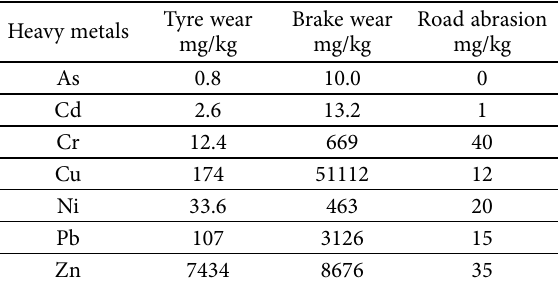
Table 3. Heavy metal fraction of tyre, brake wear and road abrasion in total